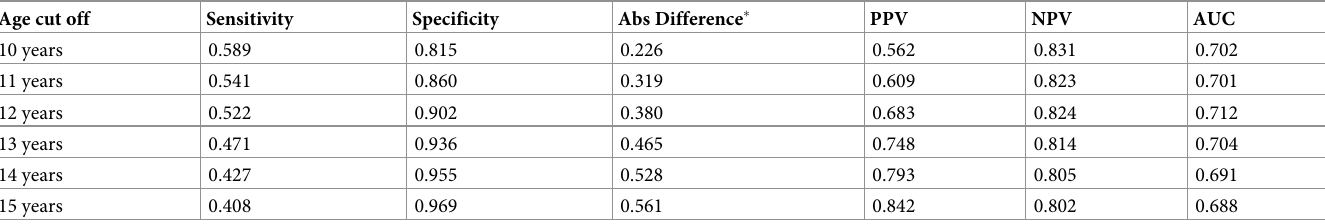
Table 5. Calculation of optimal cut-off age through validation against logic tree determination for the cohort adolescents. Age cut off